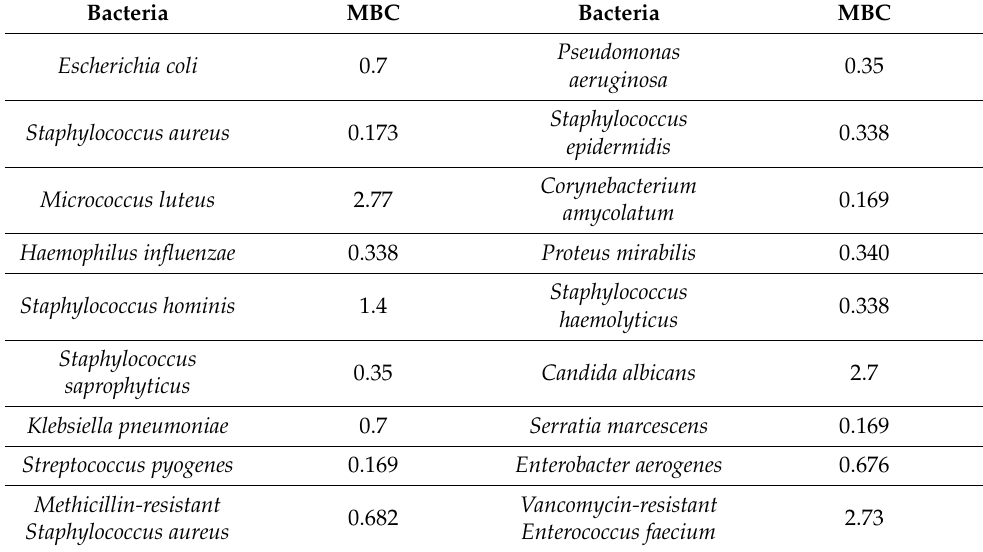
Table 1. Antimicrobial activity of